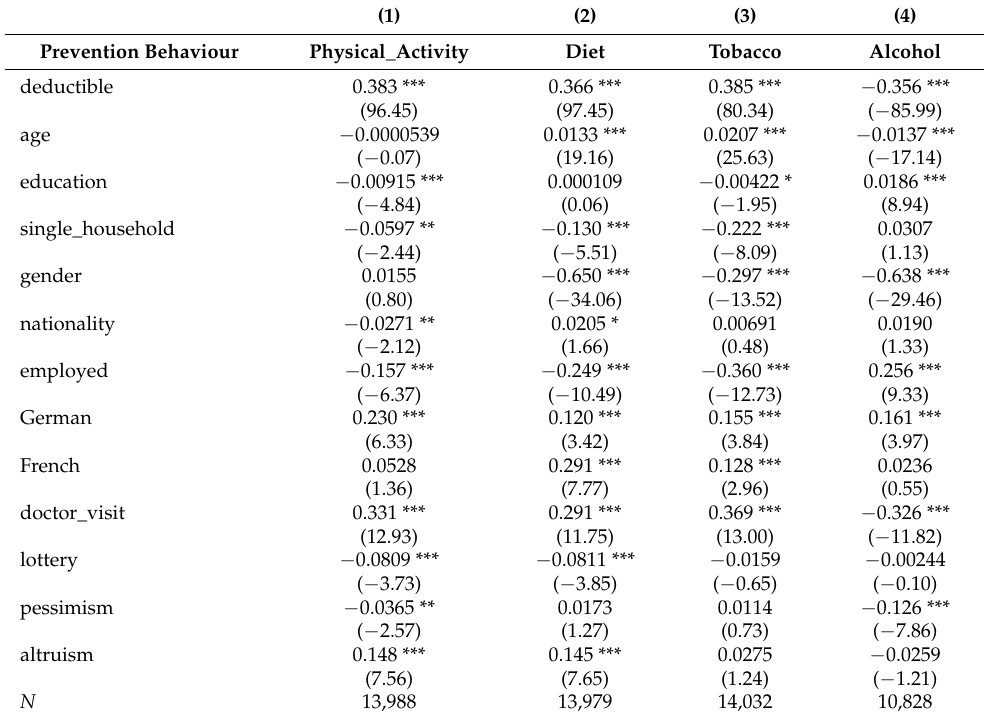
Table 5. Conditional mixed-process